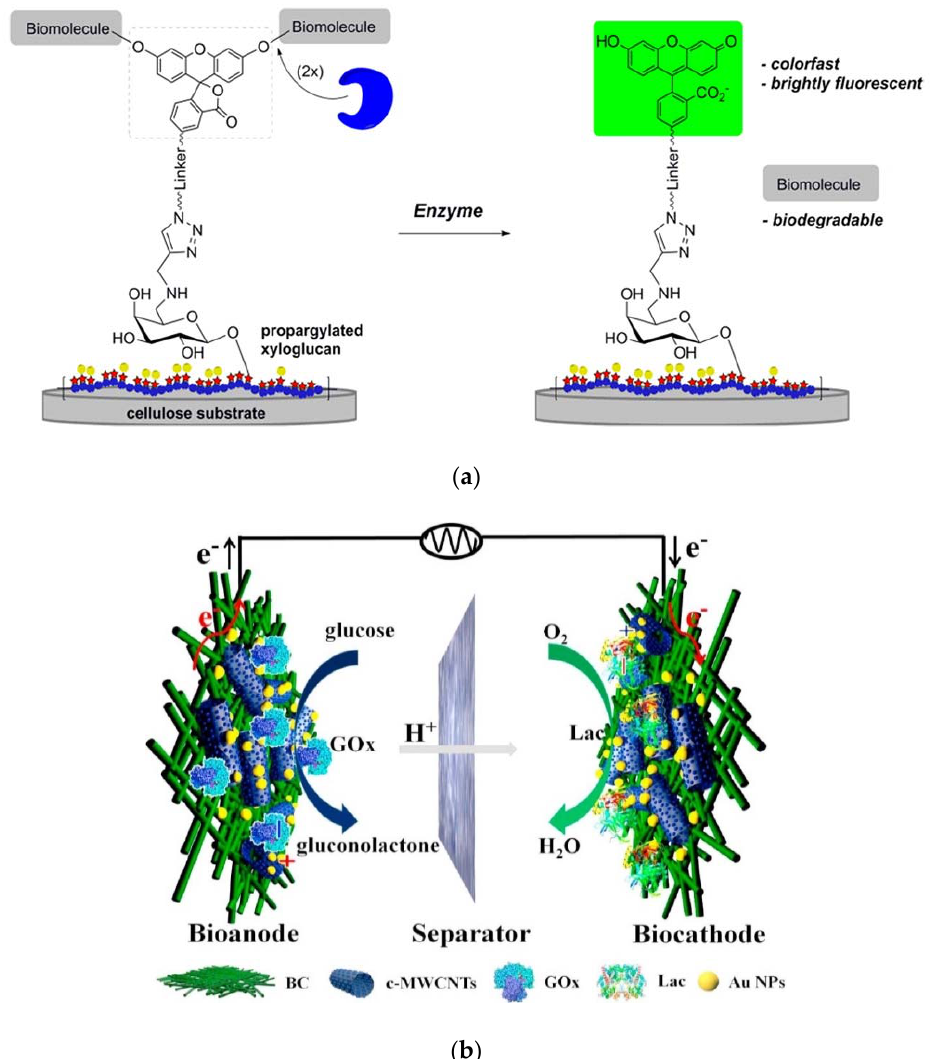
Figure 7. BC included into ( a ) esterase biosensor and ( b ) glucose oxidase biosensor. Reprinted with permission from ( a ) [129] and ( b ) [130]. Copyright (2016) American Chemical Society and (2018) Elsevier.